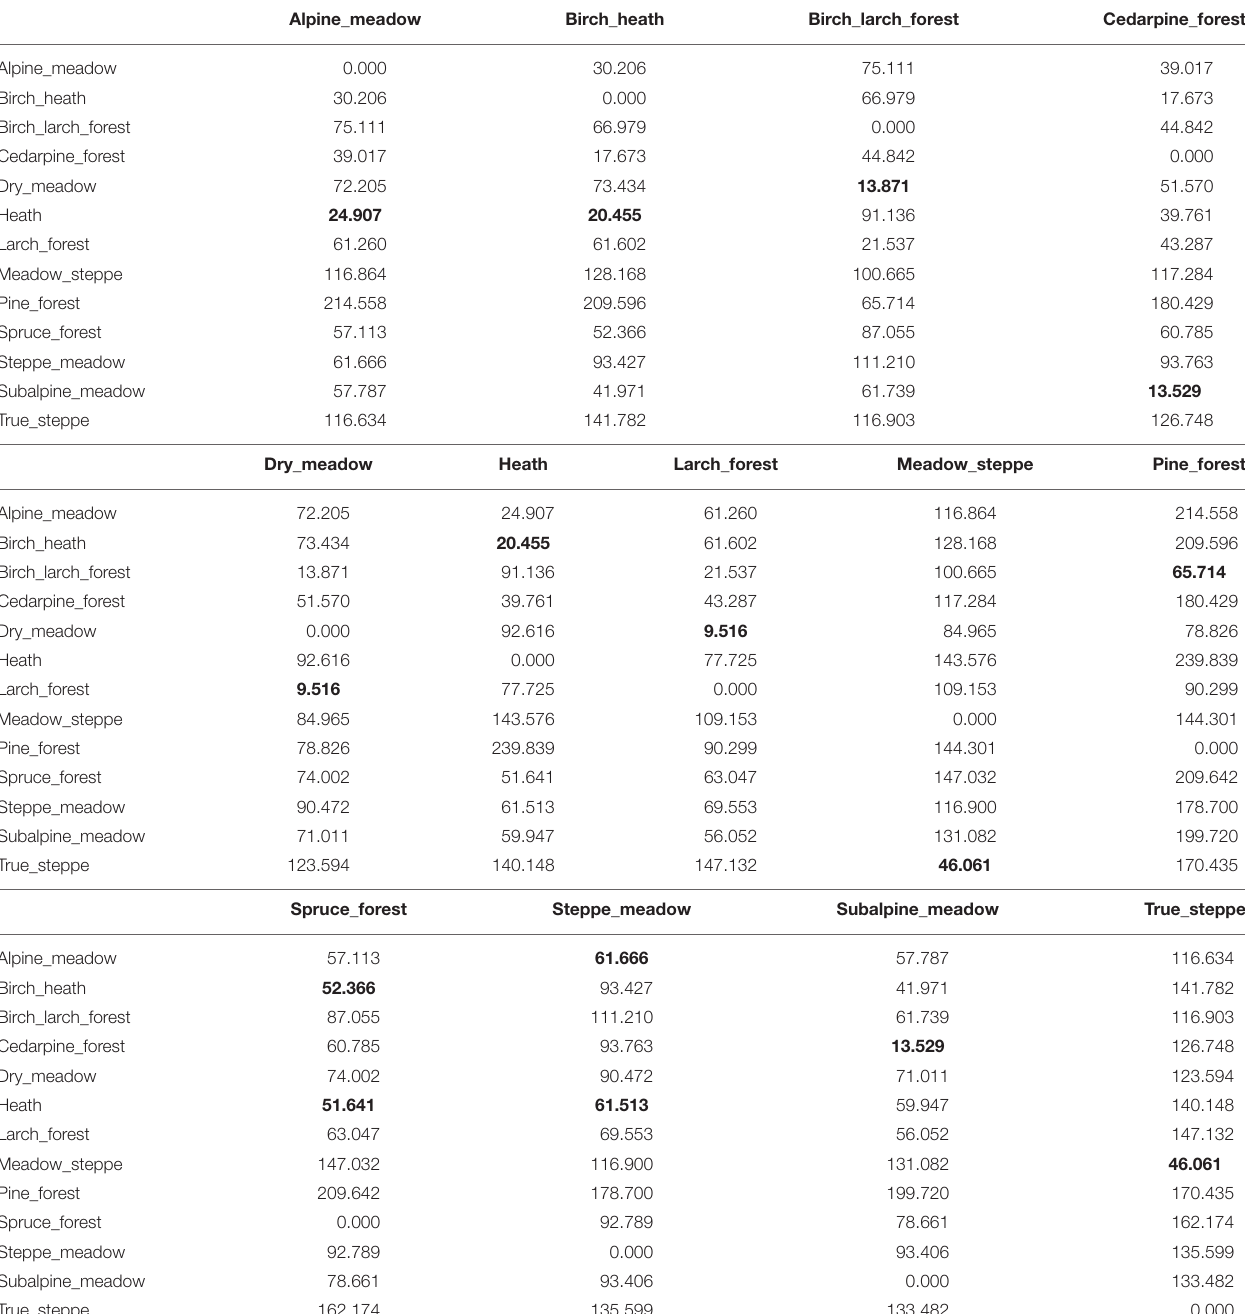
TABLE 2 | Results of discriminant analysis performed on aggregated phytolith morphotype percentages using squared Mahalanobis distance between groups (shortest distance in bold shows most similar